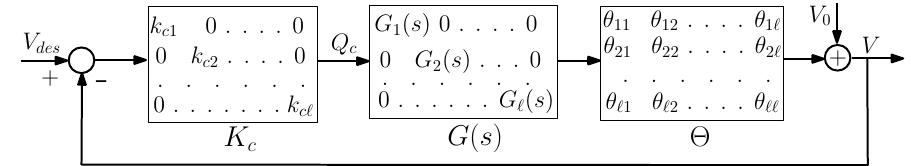
Figure 2. Decentralized control